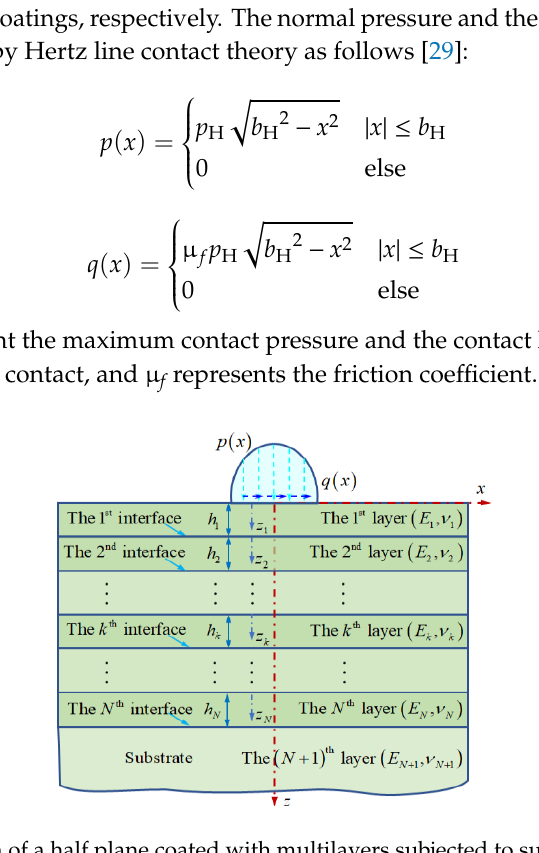
Figure 1. Illustration of a half plane coated with multilayers subjected to surface contact loading.